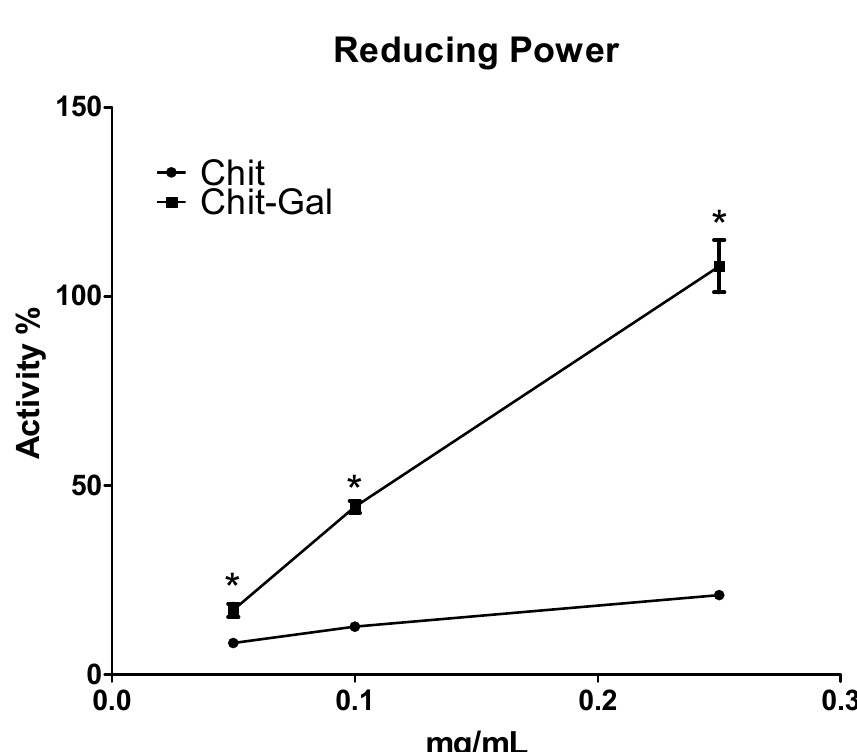
Figure 9. Reducing power of the samples. The * indicates a statistical di ff erence ( p < 0.05).